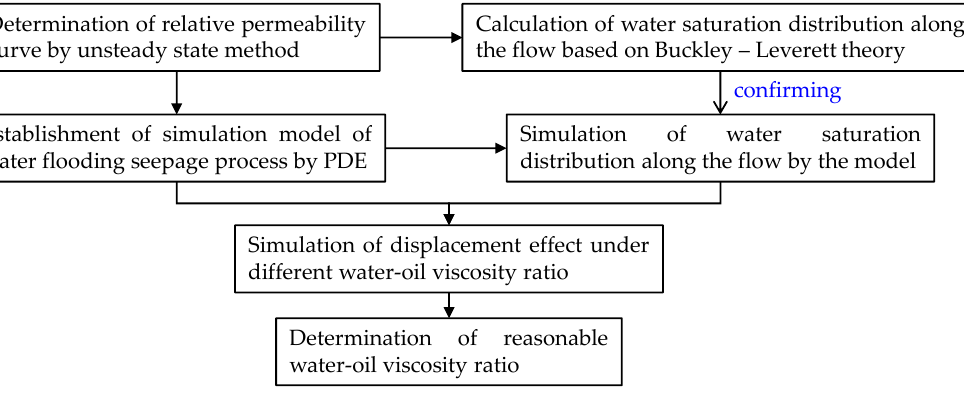
Figure 1. Schematic of the research process.